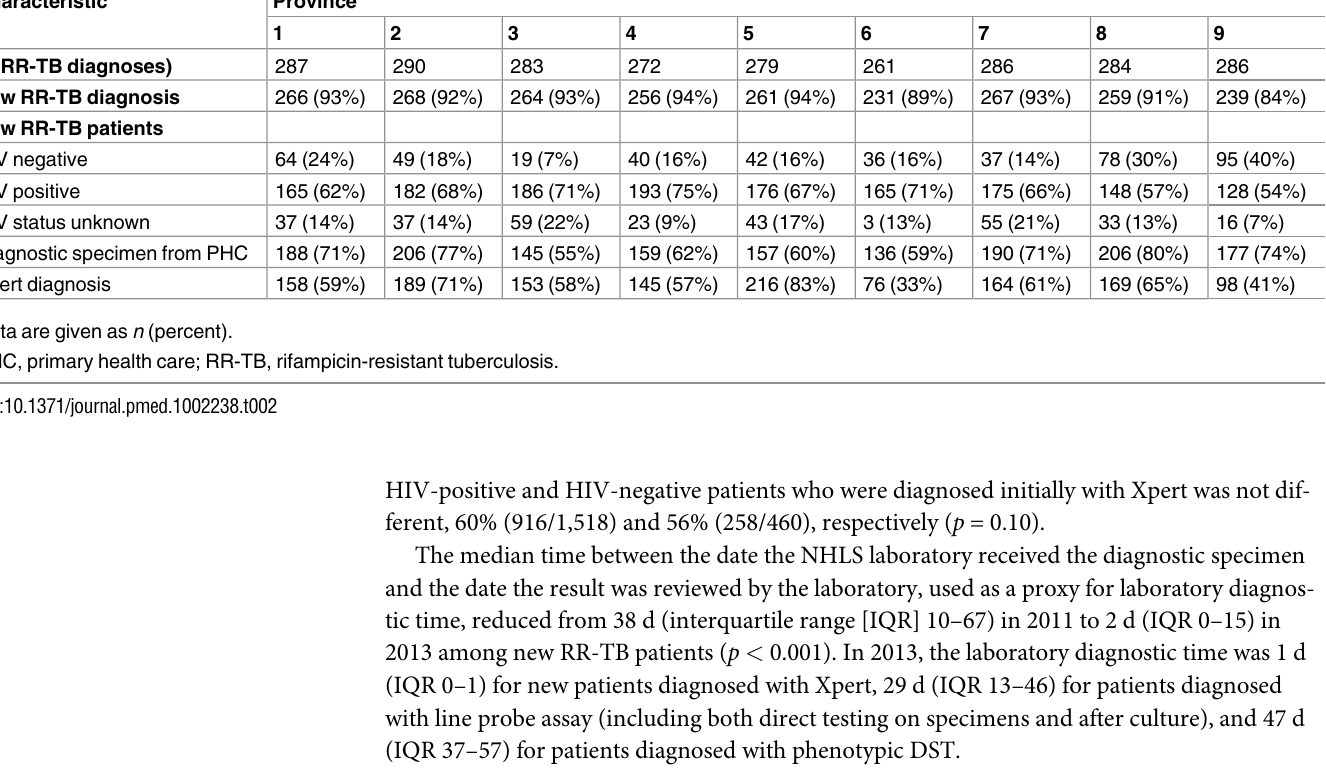
Table 2. New rifampicin-resistant tuberculosis patients and their HIV status, diagnosing facility, and Xpert diagnosis across the nine South Afri- can provinces (2013 cohort). Characteristic